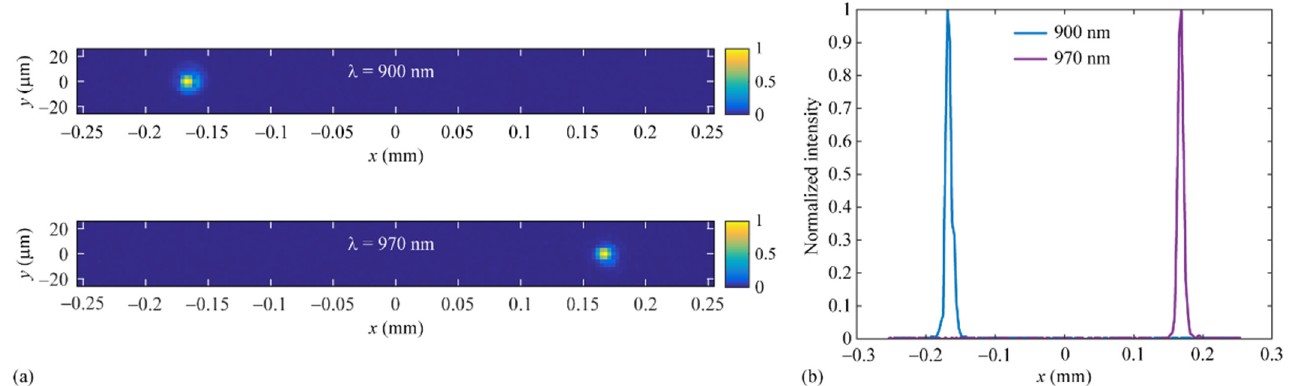
Figure 10. ( a ) Normalized measured two-dimensional intensity distributions generated by the fabricated MWDL [Figure 7b] at the design wavelengths λ 1 = 900 nm and λ 2 = 970 nm; ( b ) Cross- sections of the normalized distributions along the x axis.